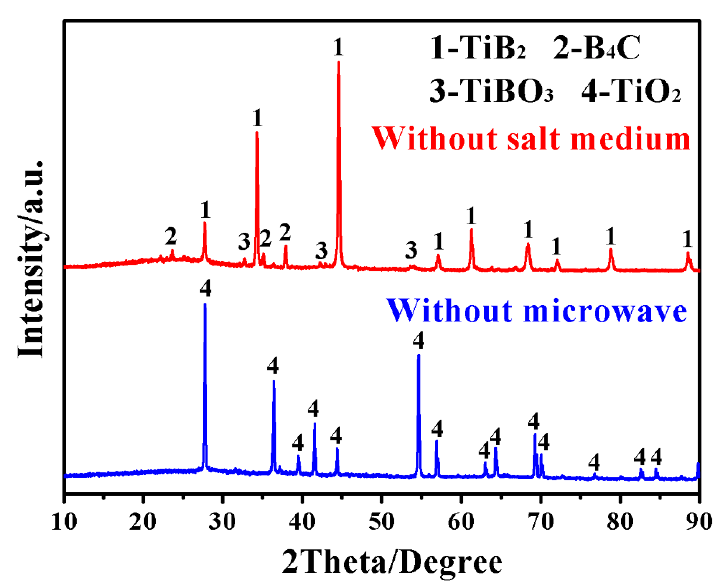
Figure 3. Phase formation in MSM-BCTR samples resultant from 20 min firing at 1200 °C, using solely microwave heating or molten-salt medium.